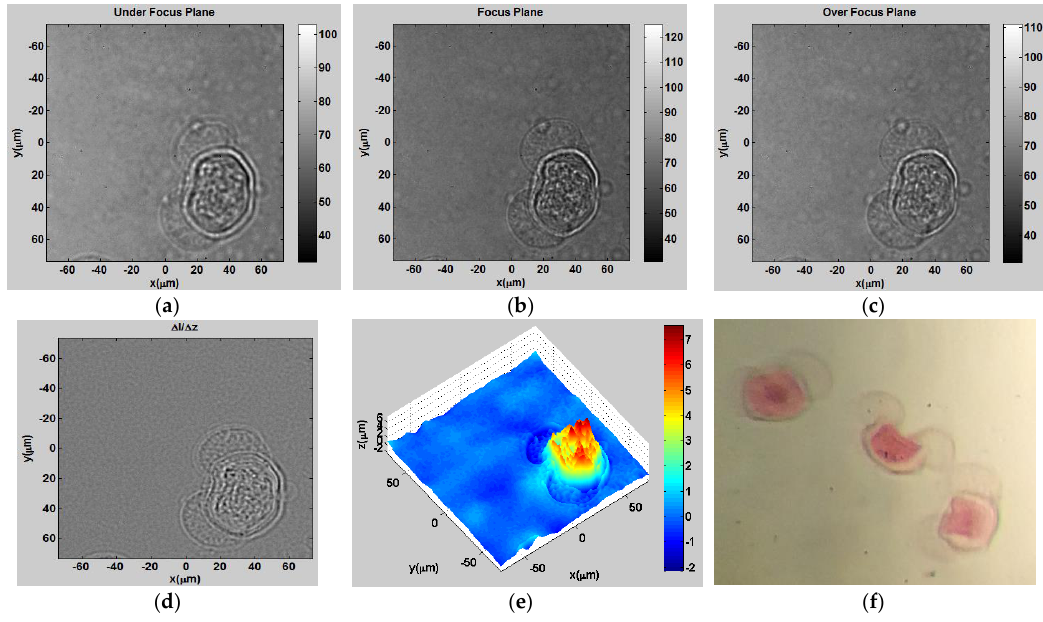
Figure 9. ( a – c ) Intensity distributions of dried pine pollen cells at 𝛥 z = 1, 0, −1 mm; ( d ) Derivative of intensity images over the propagation direction; ( e ) Height distribution converted from phase [7]; ( f ) Pine pollen image seen under a bright field microscope.